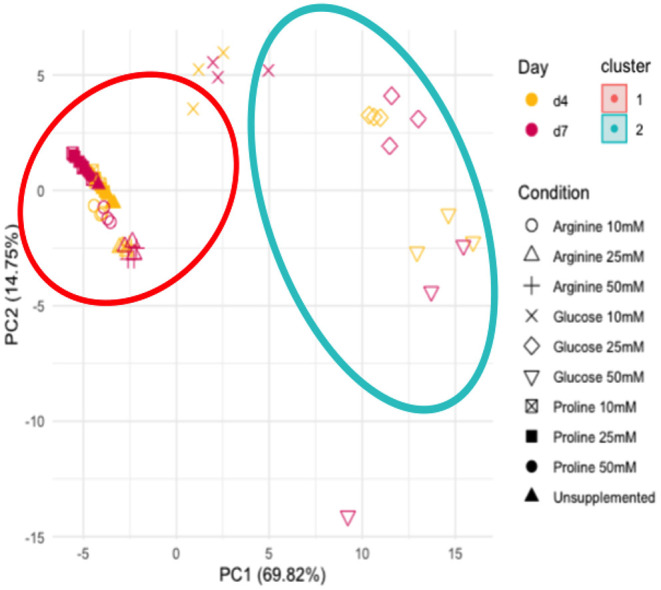
Principle component analysis of all metabolite concentrations, unsupplemented and supplemented biofilms and the sterile saliva. Unsupplemented, unsupplemented control.